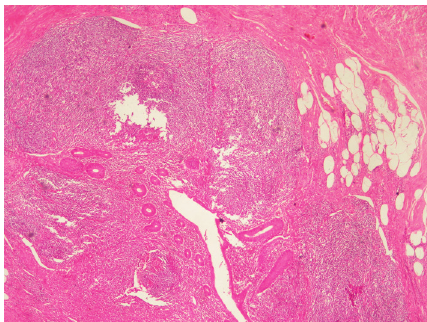
Figure 1: Milky white lymphangietasic area of the jejunal segment immediately distal to the Treitz ligament, seen from the left and the right.